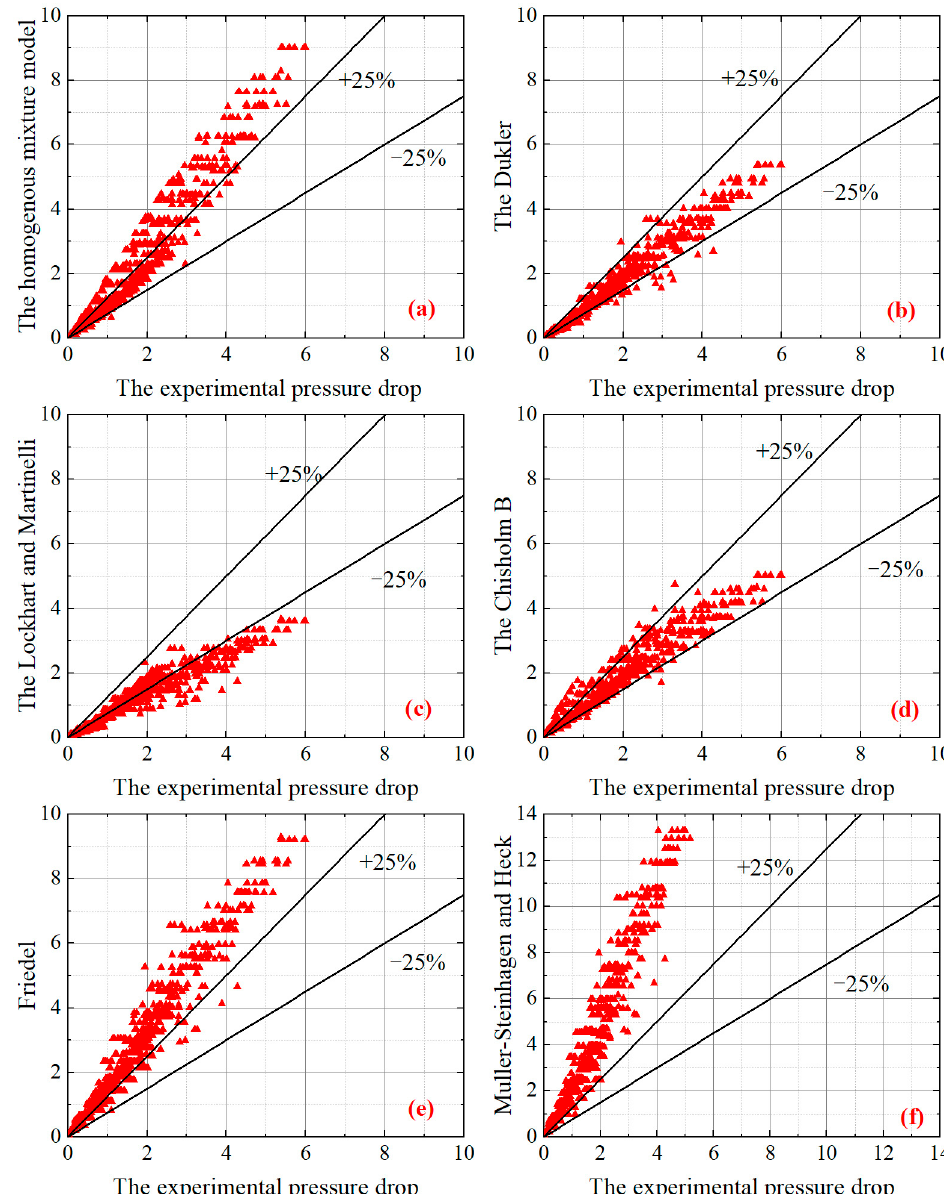
Figure 11. Comparison between the experimental values and the calculated values based on differ- ent correlations: ( a ) Homogenous; ( b ) Dukler; ( c ) Lockhart–Martinelli; ( d ) Chisholm B coefficient; ( e ) Friedel; ( f ) Muller and Heck.